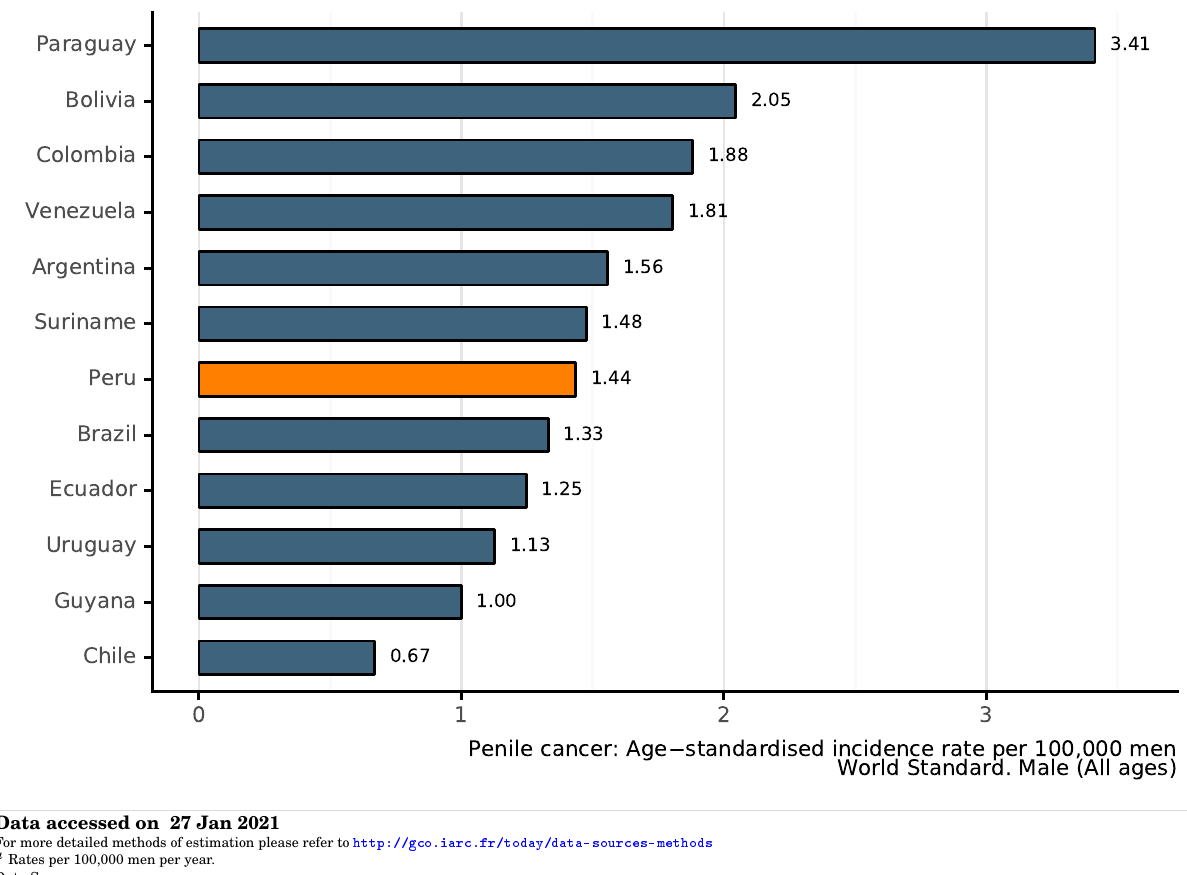
ages)ChileGuyanaUruguayEcuadorBrazilPeruSurinameArgentinaVenezuelaColombiaBoliviaParaguay 0 1 2 3 Penile cancer: Age standardised incidence rate per 100,000 men World Standard. Male (All